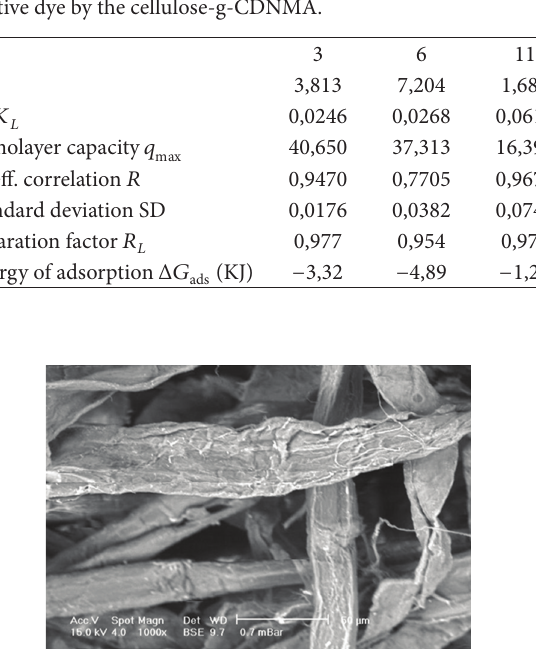
T 1: Parameters of the Langmuir isotherm for adsorption of